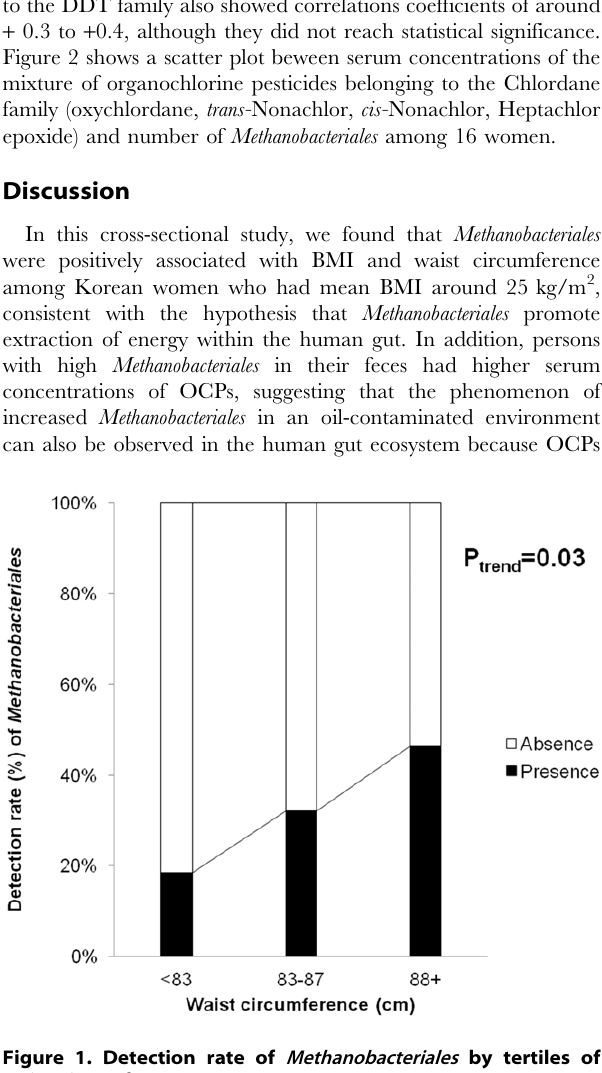
Figure 1. Detection rate of Methanobacteriales by tertiles of waist circumference (n=83).